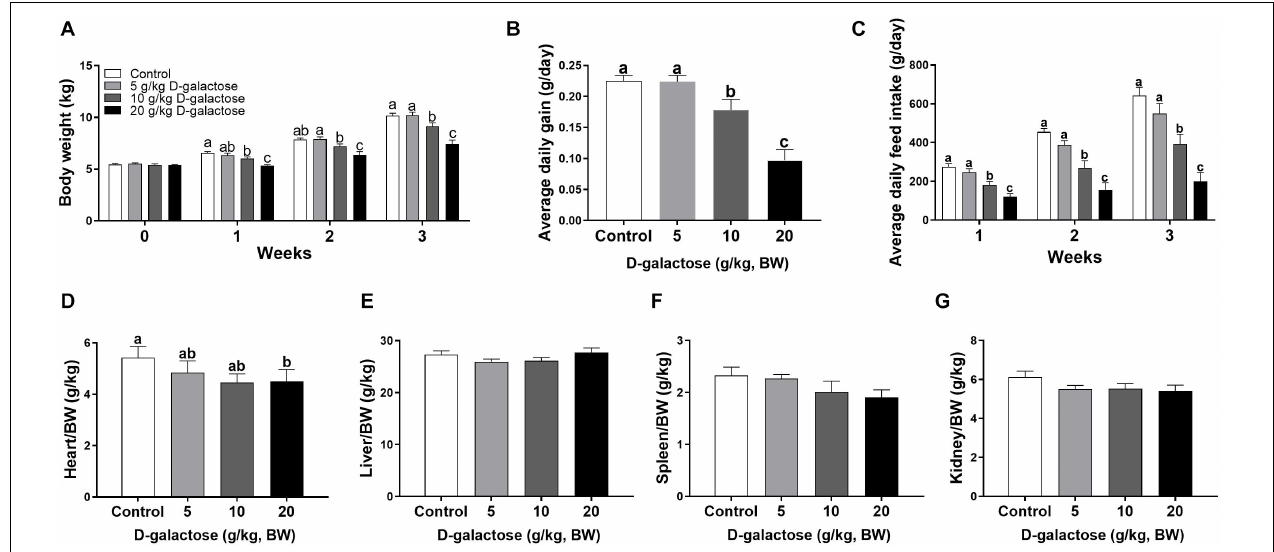
FIGURE 1 | Effects of D -galactose on growth performance. (A) Body weight; (B) Average daily gain; (C) Average daily feed intake; (D) Relative weight of heart to body weight; (E) Relative weight of liver to body weight; (F) Relative weight of spleen to body weight; (G) Relative weight of kidney to body weight. Data were expressed as the mean ± SEM. Different lower-case letters indicate a significant difference among different dosage of D -galactose ( P < 0.05).